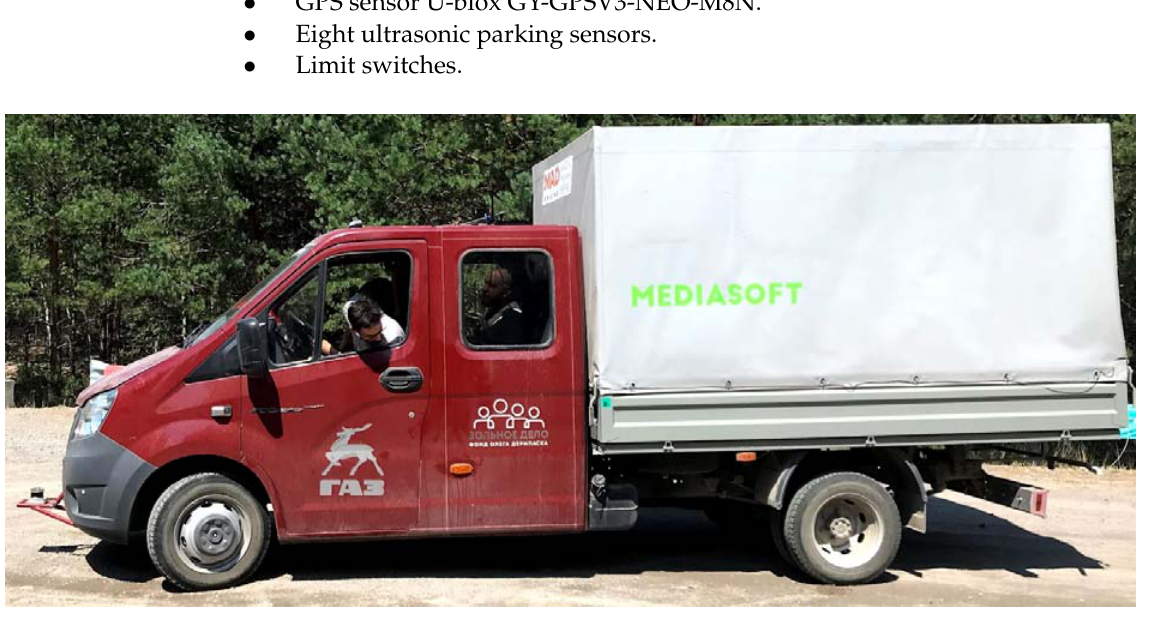
Figure 2. Self-driving truck.